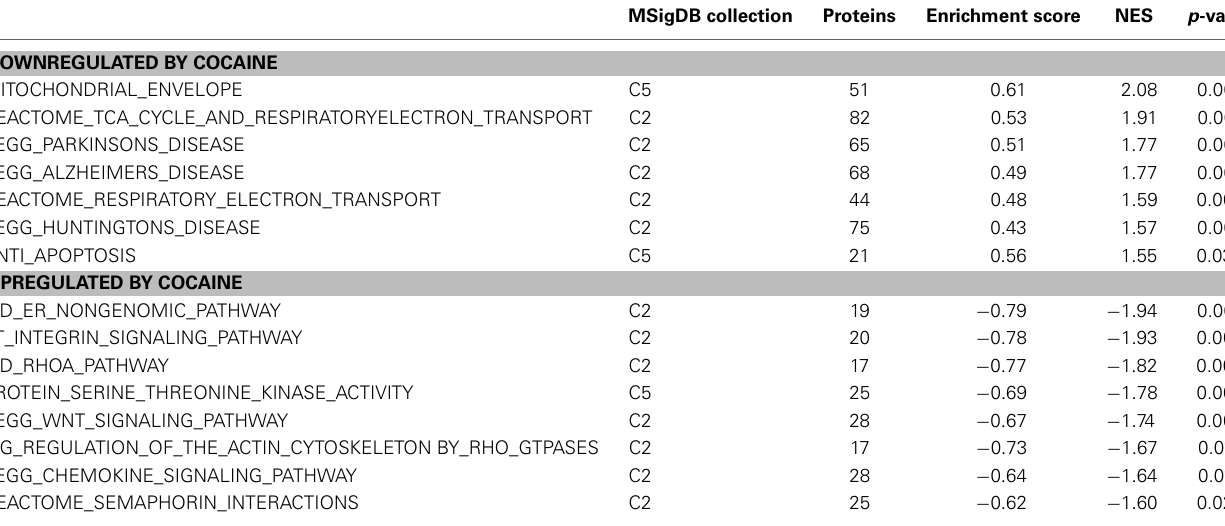
Table 2 | A selection of cocaine-regulated protein sets from the GSEA